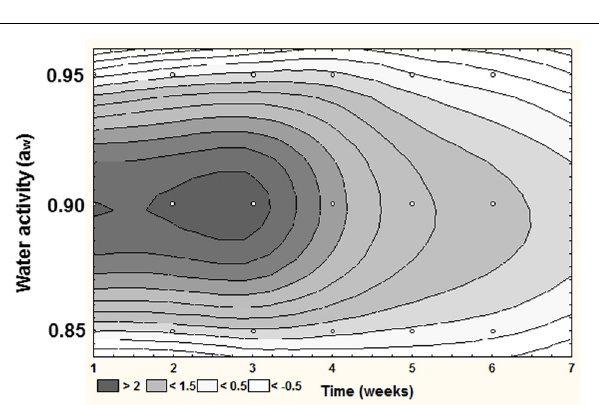
FIGURE 2 | Relative expression of aflD (nor1) gene during colonization of peanuts by Aspergillus flavus during storage. Optimum expression occurred at 0.90 a w during the first 2–3 weeks of storage at 25 ◦ C (from Abdel-Hadi et al., 2010).